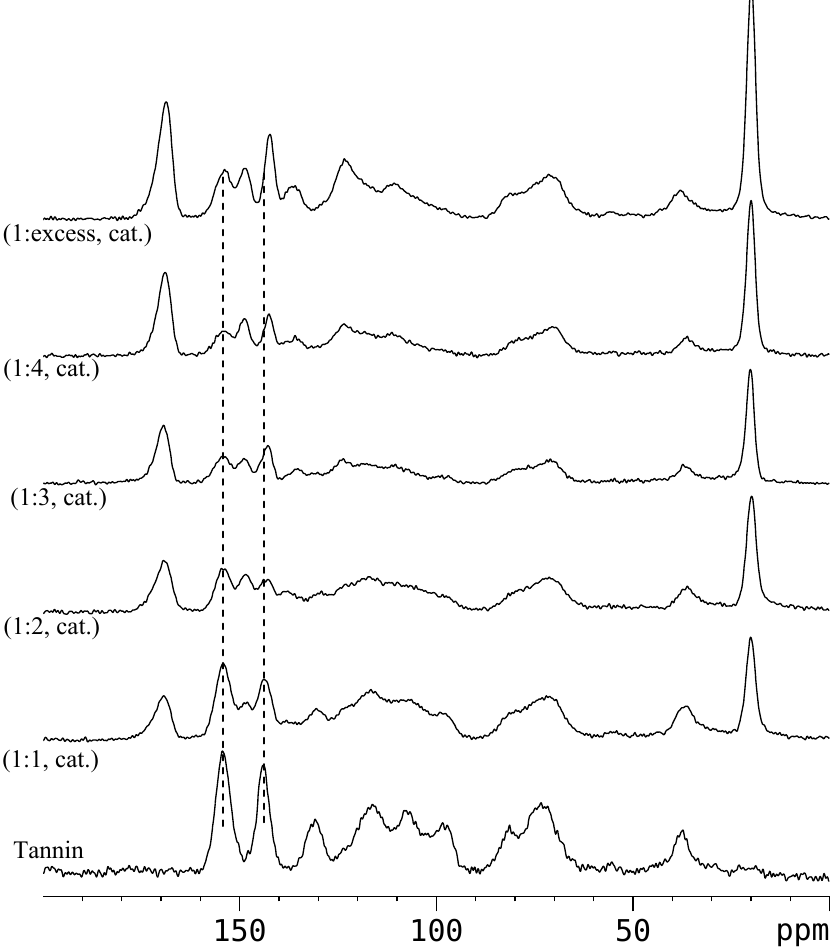
Figure 2. Comparison of solid state 13 C NMR CPMAS spectra of various pine bark tannin acetate products formed with differing molar ratio of tannin:acetic anhydride and 1-methylimidazole catalyst